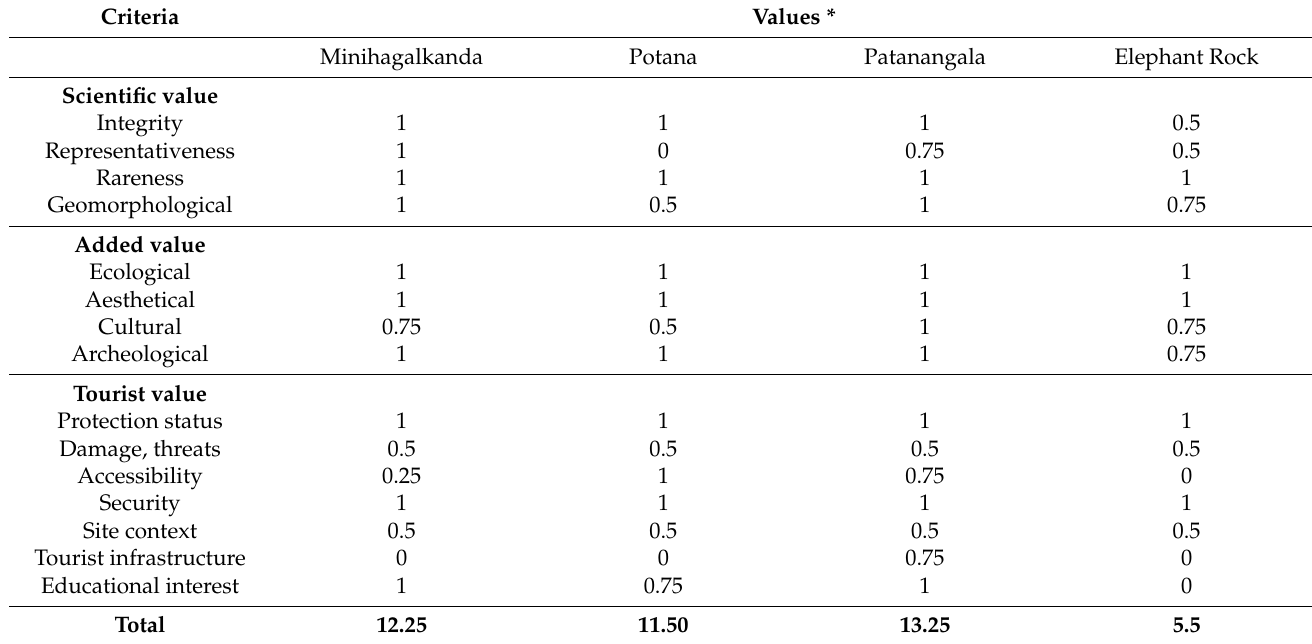
Table 3. Numerical assessment of geotourism potential of four selected geosites in Yala National Park: Minihagalkanda, Potana, Paranangala, and Elephant Rock. For detailed definitions of criteria see Table